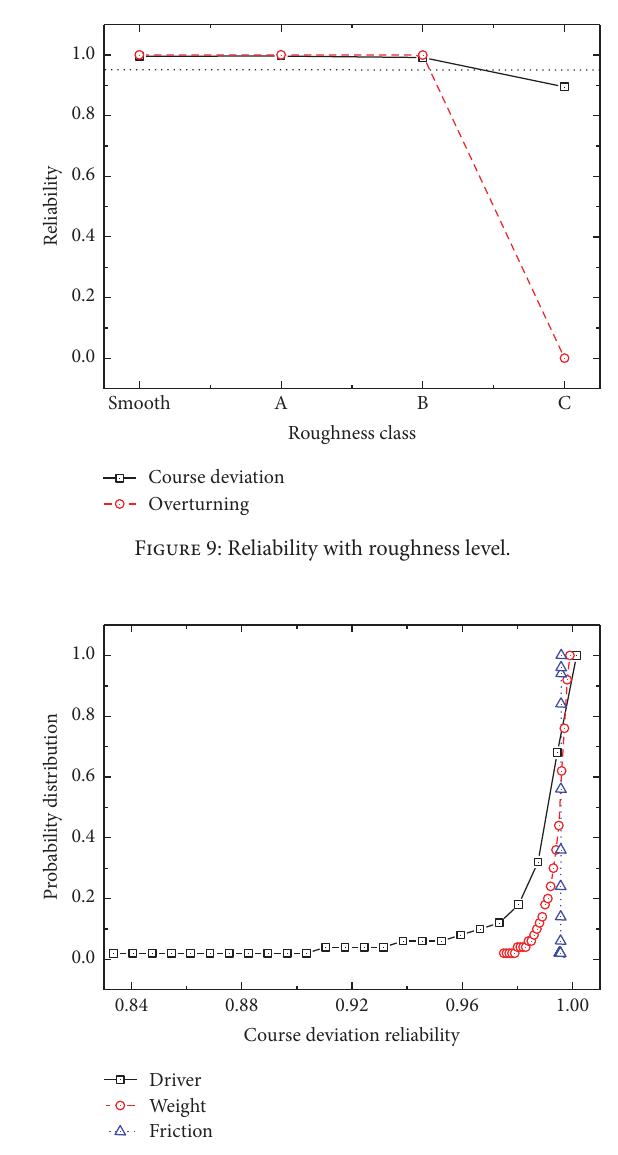
Figure 10: Probability distribution of reliability (course